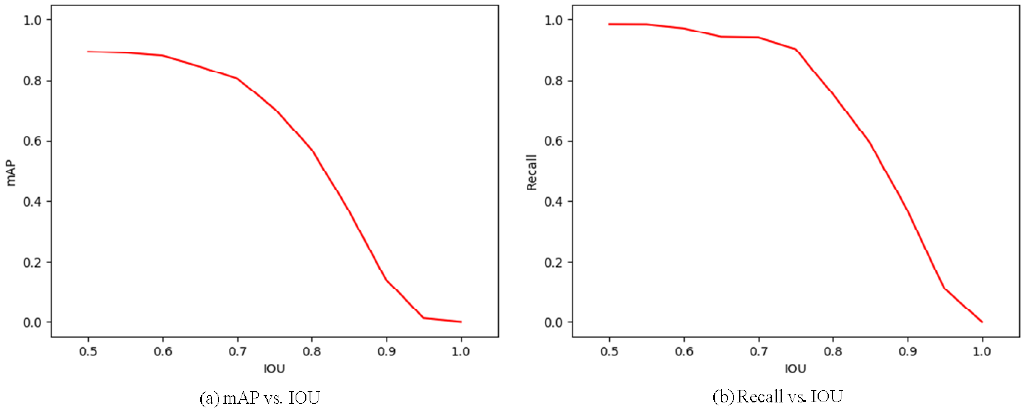
Figure 10. mAP and recall vs. intersection over union (IOU) overlap ratio on the railway traffic test